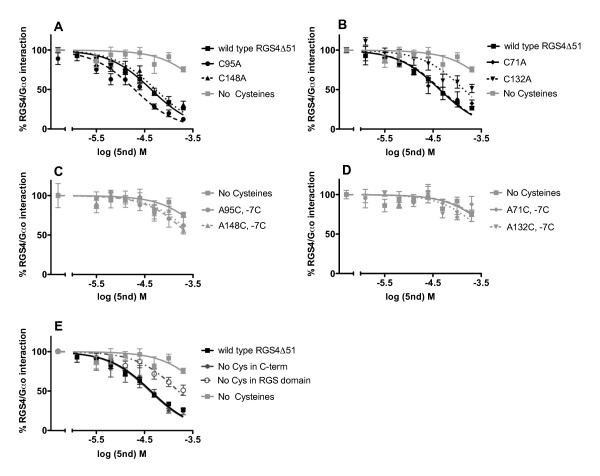
Dose curves of 5nd on various RGS4 cysteine mutants. Various concentrations of 5nd were tested for disruption of the RGS4-Gαo interaction for C95A (5 nM), or C148A (5nM) (A), C71A (5nM) or C148A (5nM) (B), A95C in the -7C (5nM), or A132C in the -7C (5nM) (C), A71C in the -7C (5nM), or A148C in the -7C (5nM) (D) or the mutant with no cysteines in the domain (20 nM) or the C-terminus (20 nM) (E) in the FCPIA (mean ± S.E.M., n ≥ 3). See Table 2 for statistics.